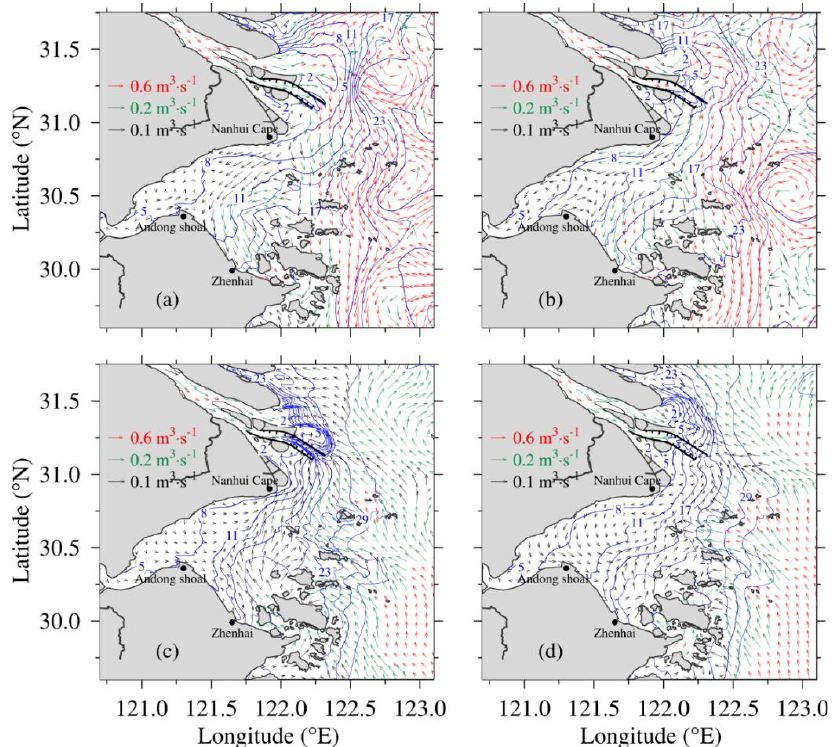
Figure 8. Distribution of the RUWF and salinity in the surface layer (upper panel) and bottom layer (lower panel) during neap tide ( a , c ) and spring tide ( b , d ) in summer (contours represent salinity and the arrows represent RUWF).